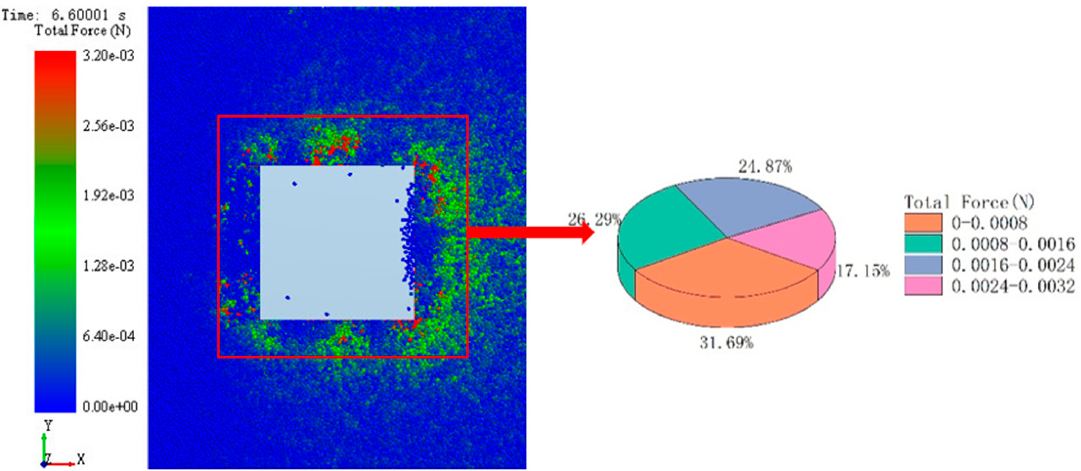
Figure 14. Stress distribution of particles under ordinary track shoe.